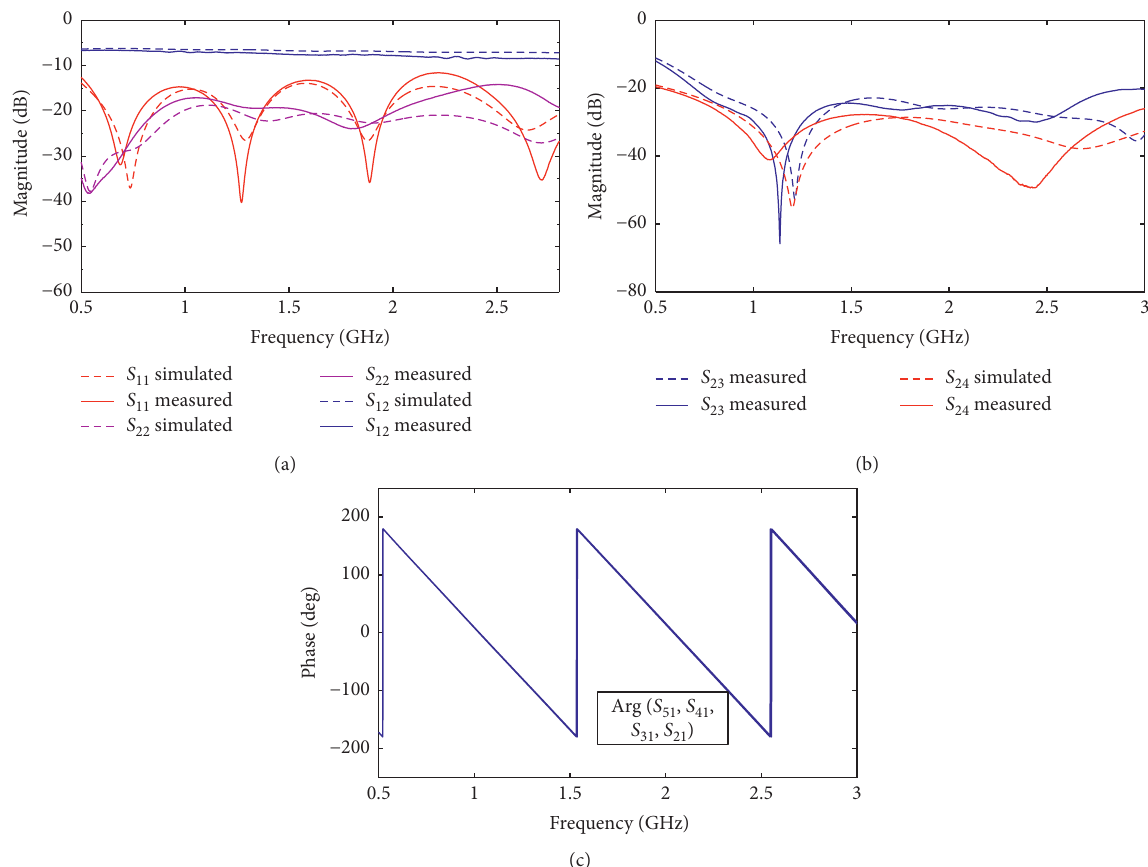
Figure 17: Simulated and measured S parameters of the power combiner. (a) Insertion loss and return loss at input and output ports. (b) Isolation between adjacent and opposite input ports. (c) Transmission phase.